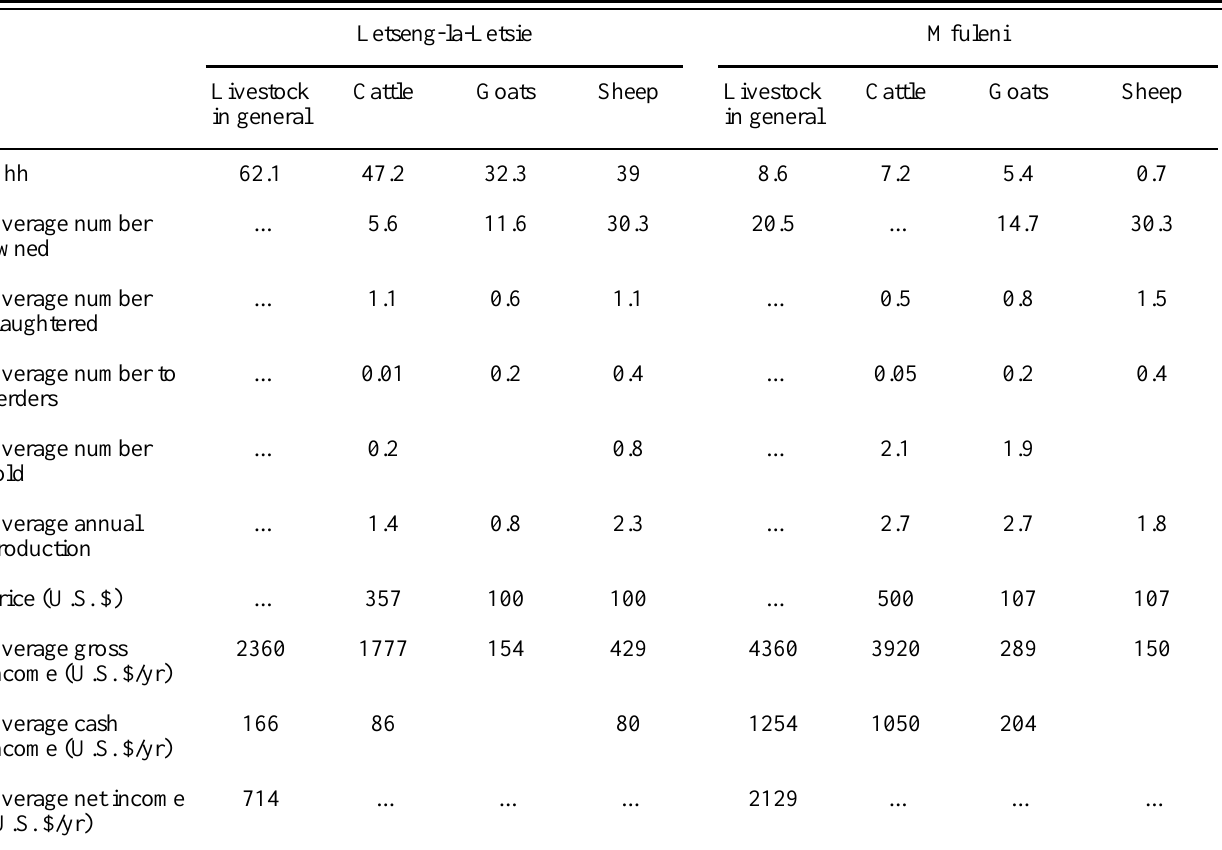
Table 5 . Average incomes of livestock owners around Letseng-la-Letsie over the past year; %hh = percentage of households. Letseng-la-Letsie Mfuleni Livestock Cattle Goats Sheep Livestock Cattle Goats in general in general